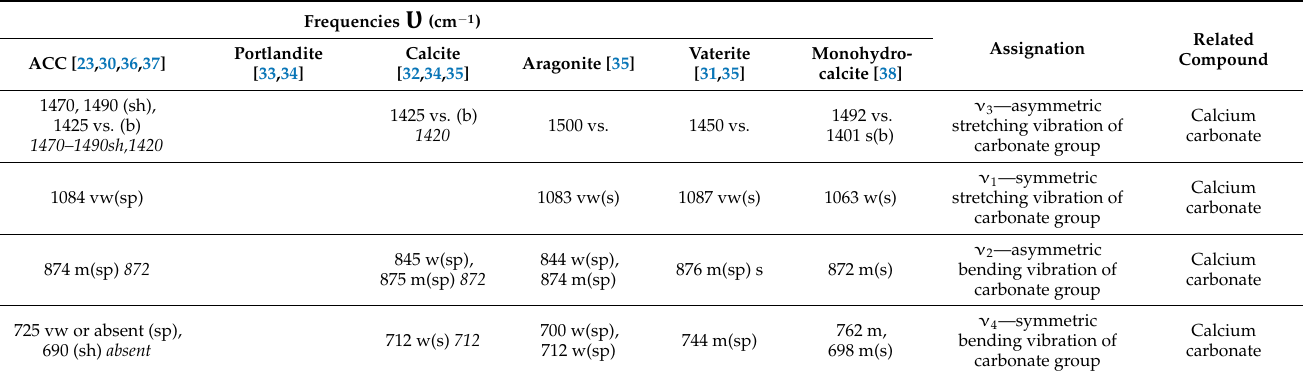
Table 4. Cont. Table 4. Diagnostic IR band frequencies obtained in this study and from the literature [30 – 38].